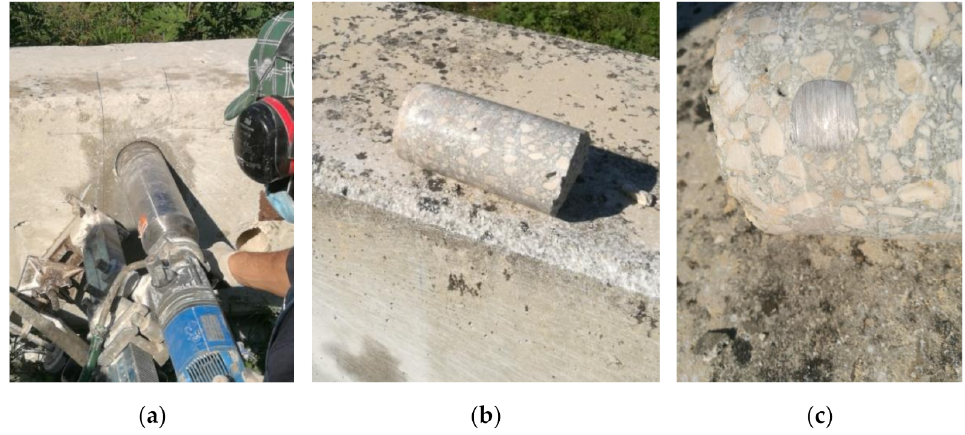
Figure 5. Core drilling C1 ( a ); sample C2 ( b ); visual inspection of cores ( c